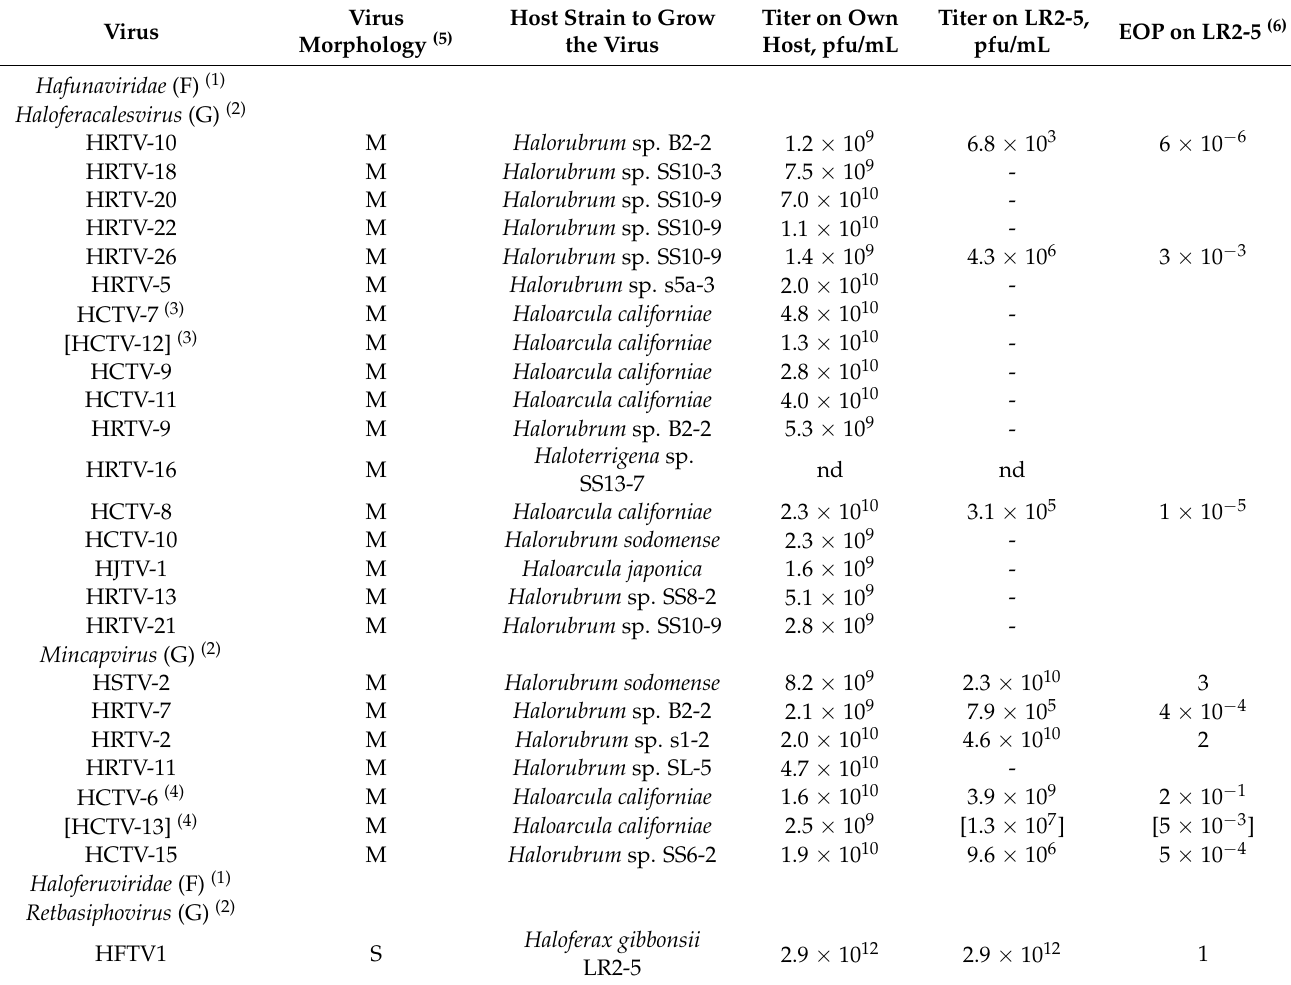
Table 1. Haloferax gibbonsii LR2-5 infecting viruses and the closely related virus isolates assigned to the same